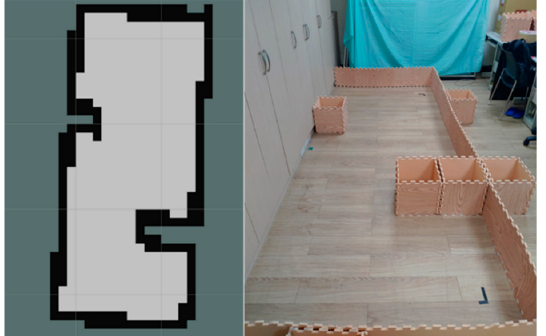
Figure 10. The experimental map.